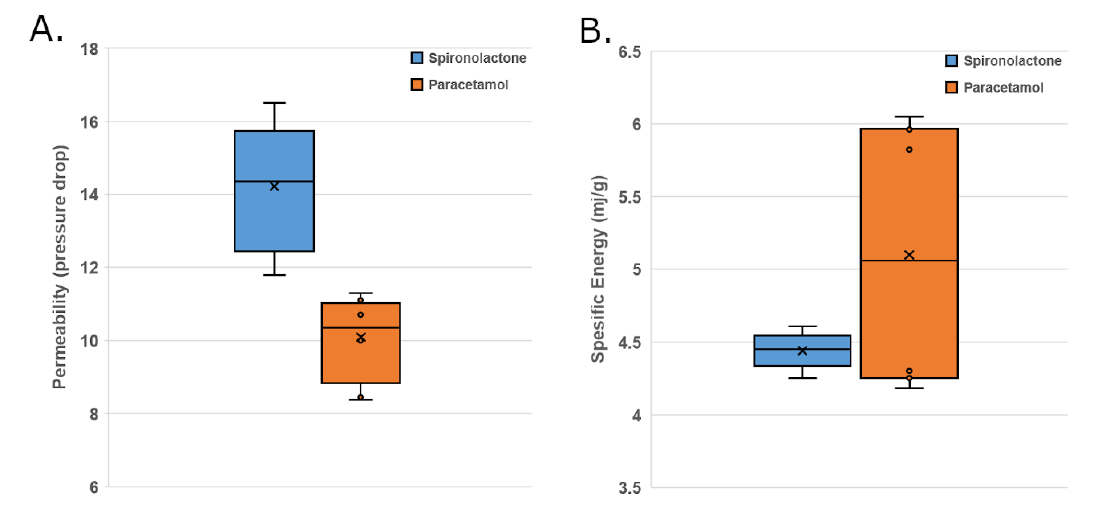
Figure 3. Flowability of powder blends. ( A ) permeability and ( B ) Specific energy.